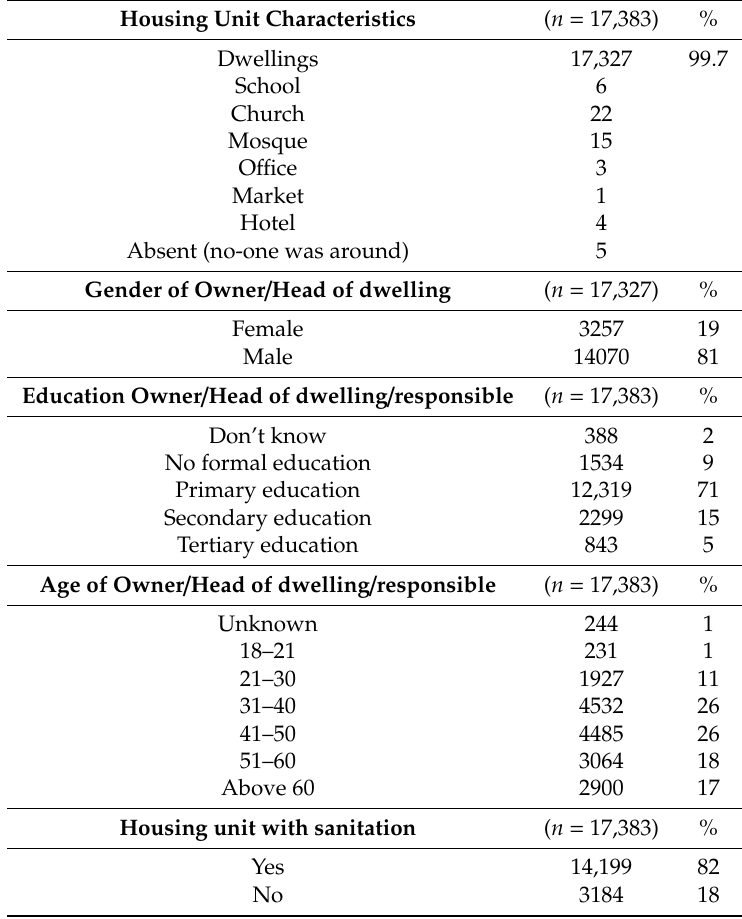
Table 1. Statistics of housing units surveyed in Babati Town